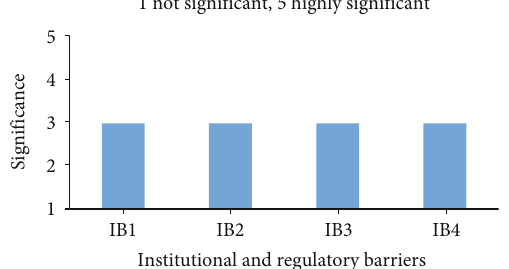
Figure 5: Signi fi cance of the institutional and regulatory barriers to the promotion of RE. IB1: lack of long-term political strategy on energy; IB2: direct interest and participation of the State in competitive sectors; IB3: lack of a regulatory framework for competition; IB4: lack of coordination among relevant institutions.